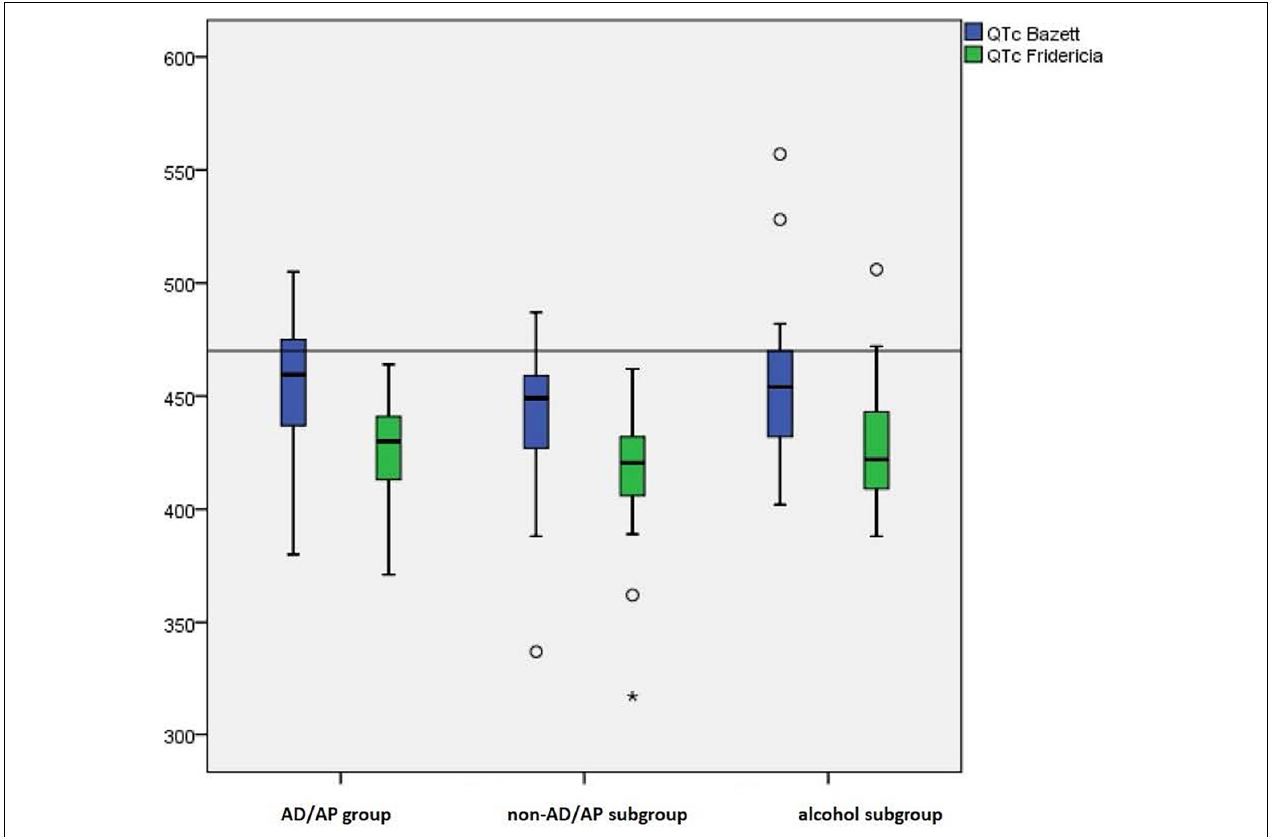
FIGURE 3 | Median values and percentiles (box plots) of the QTc-B and QTc-F data set in the AD/AP group and both control groups.